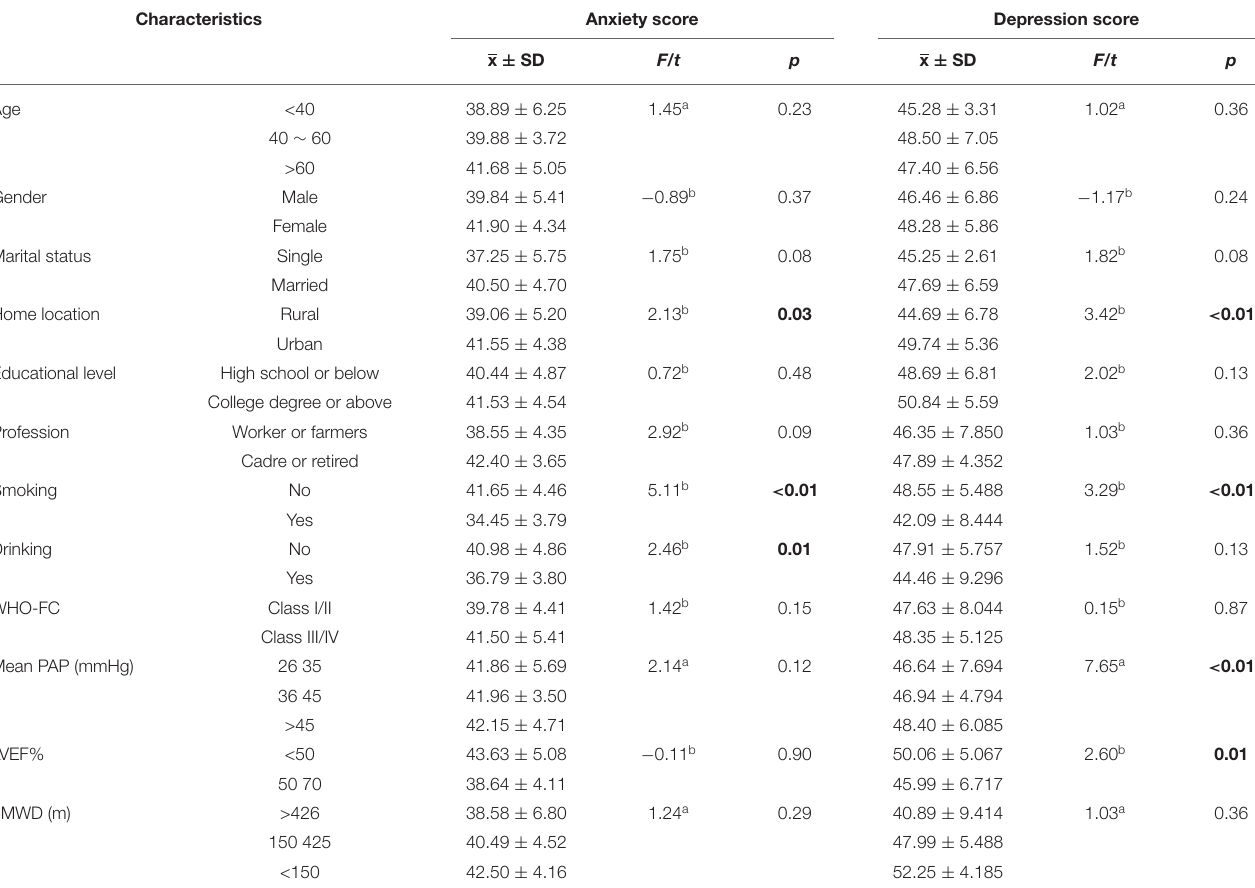
TABLE 2 | Univariate analysis of anxiety, depression scores, and general characteristics.